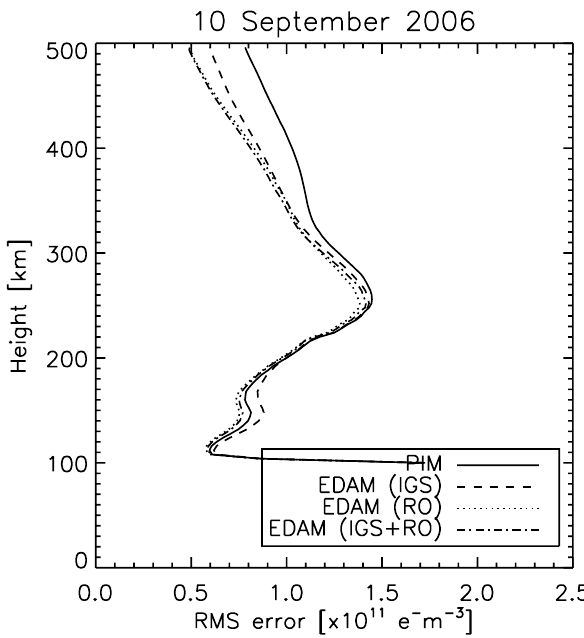
Fig. 8. RMS error between ionospheric models and Abel transform vertical profiles at 5km height steps on 10 September 2006 (quiet geomagnetic conditions). The models are: PIM (solid line); EDAM assimilating IGS data only (dashed line); EDAM assimilating COS- MIC RO data only (dotted line); and EDAM assimilating IGS and COSMIC RO data (dot-dash